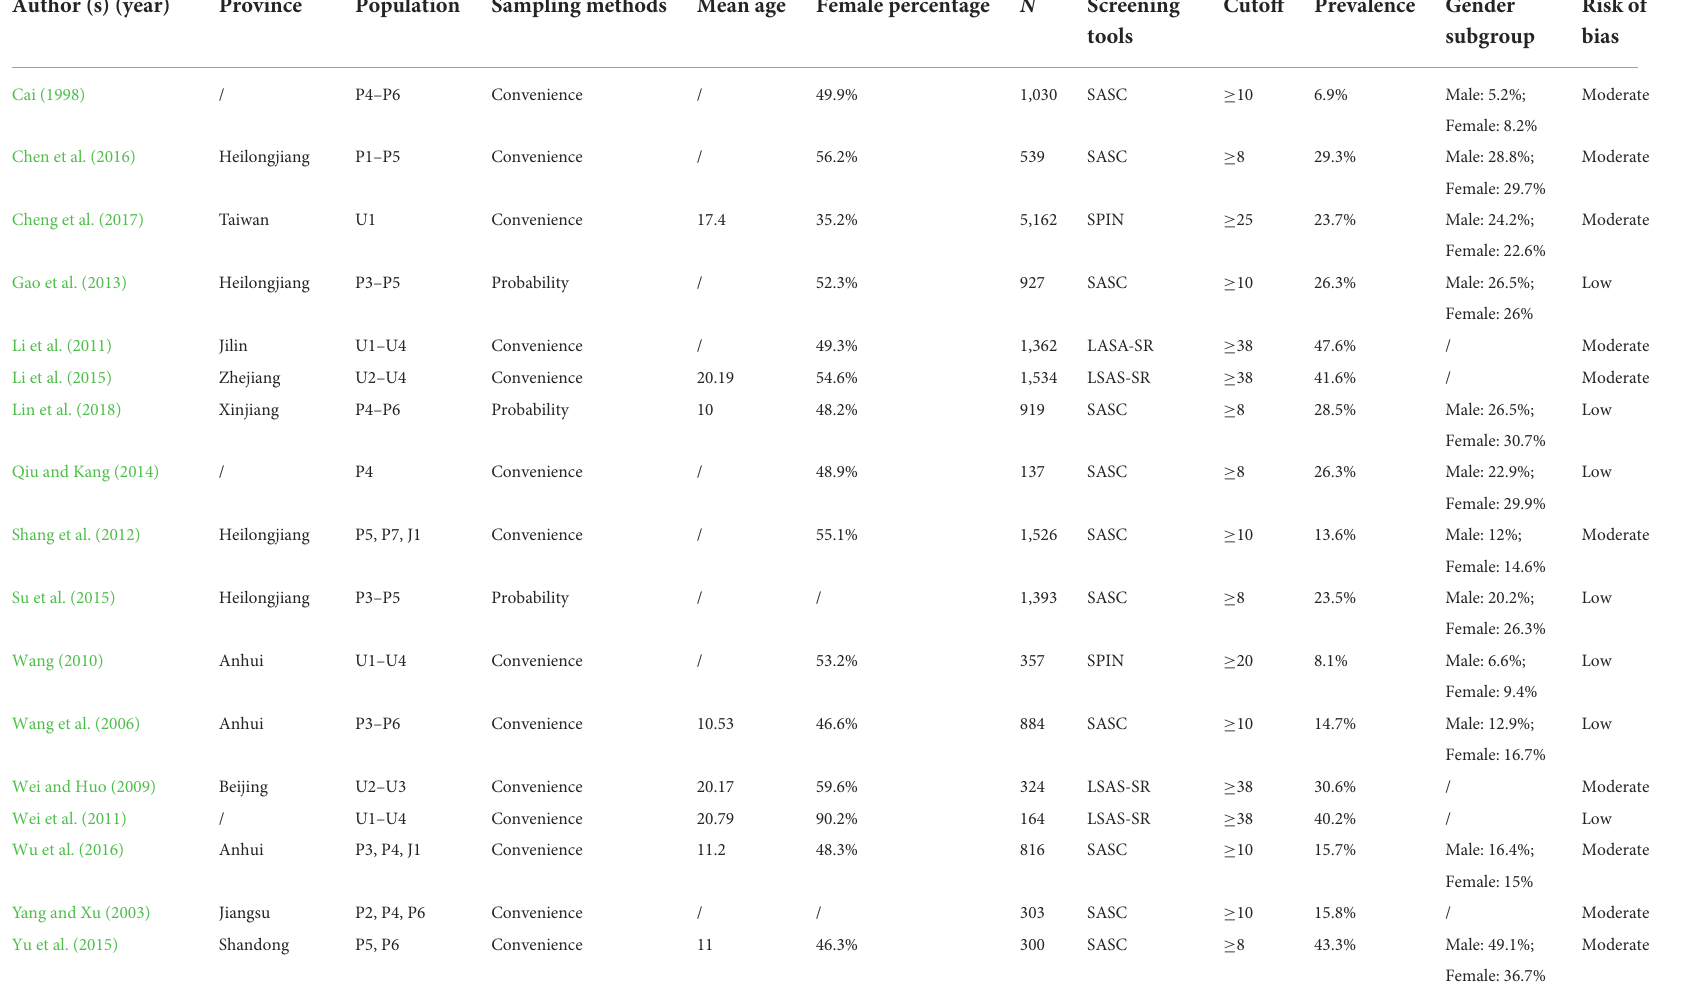
TABLE 2 Social anxiety symptoms: study characteristics of the included studies. Author (s)